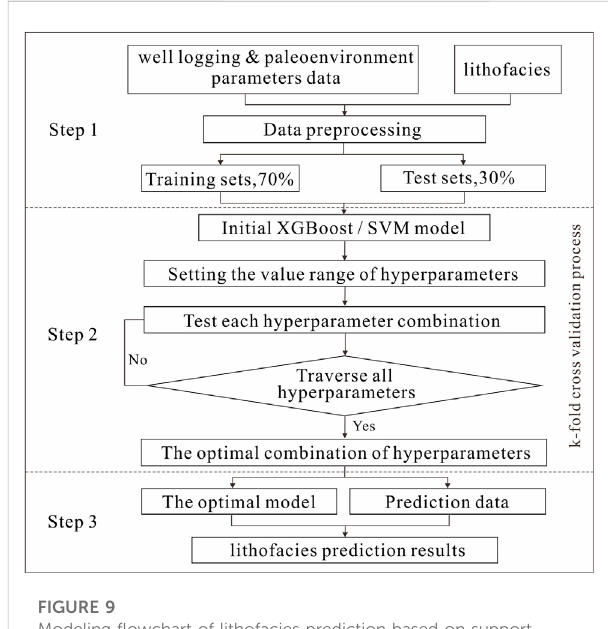
FIGURE 9 Modeling fl owchart of lithofacies prediction based on support vector machine (SVM) and extreme gradient boosting (XGBoost)